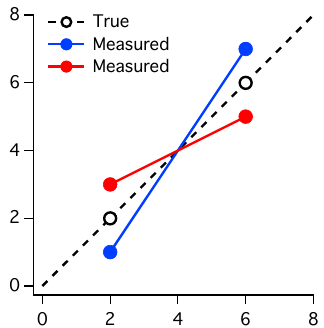
Figure B1. Two lines, each defined by measurements of the true points (2,2) and (6,6), that are in error by + 1 or − 1 in the ordinate